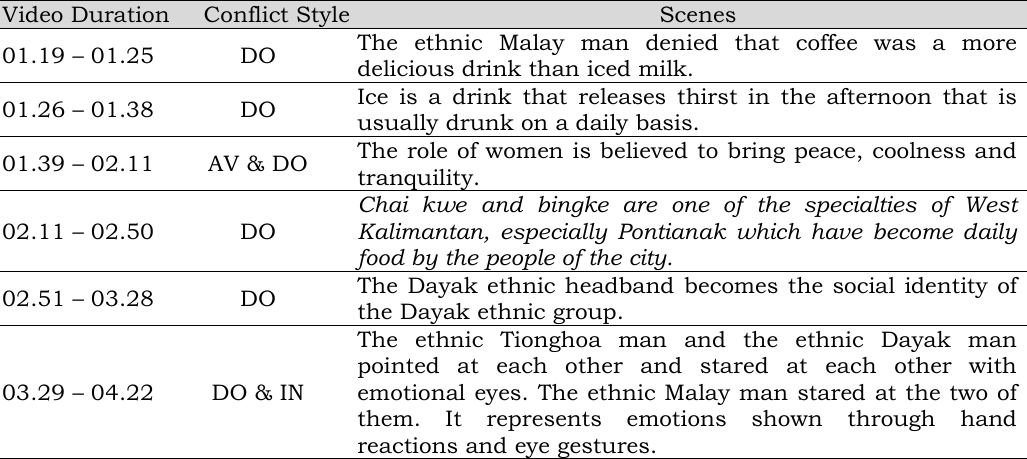
Table 5. Meaning of conflict style in video as Symbol Video Duration Conflict Style